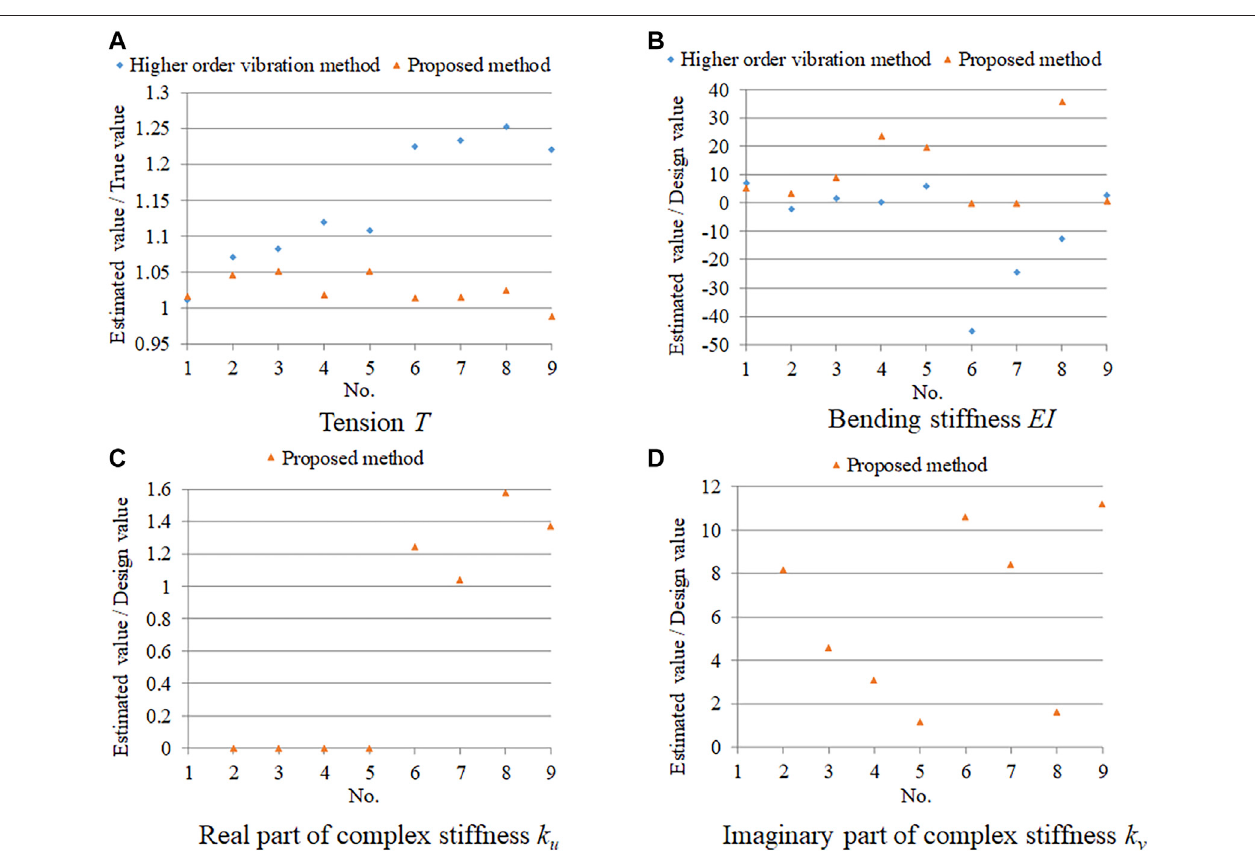
Frontiers in Built Environment |